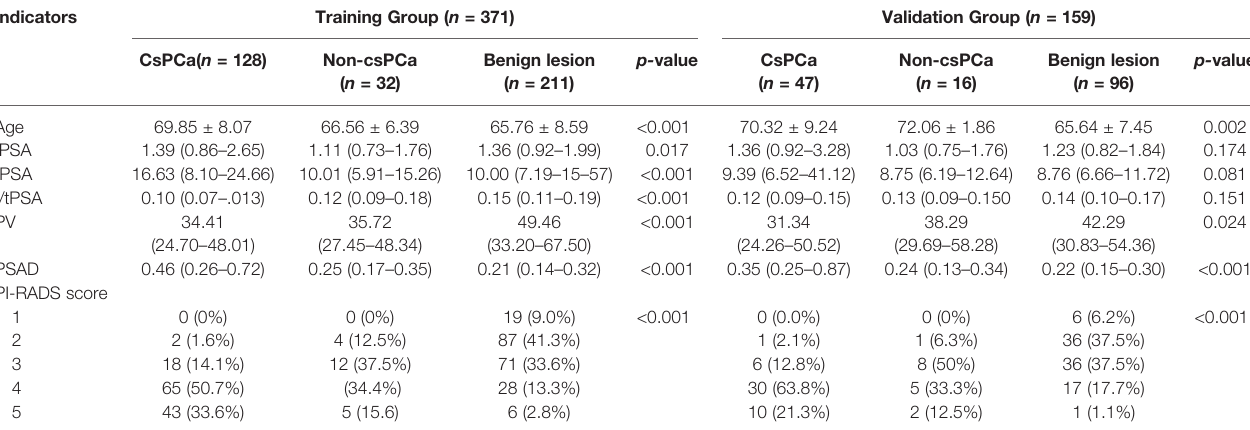
fPSA,freePSA;tPSA,totalPSA;f/tPSA,free/totalPSA;PV,prostatevolume;PSAD,PSAdensity;csPCa,clinicalsigni fi canceprostatecancer;PI-RADSscore,prostateimagingreporting and date system score.